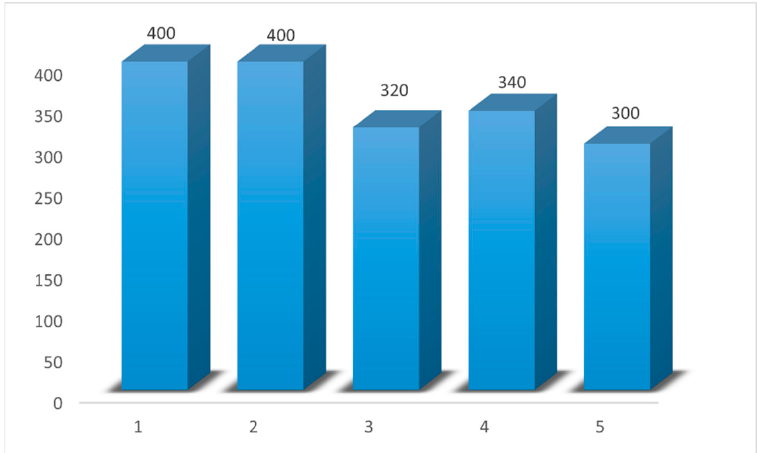
Figure 9. Sizes of samples necessary to reach the rejection of 𝐻 (cid:2868) for the simulated example.